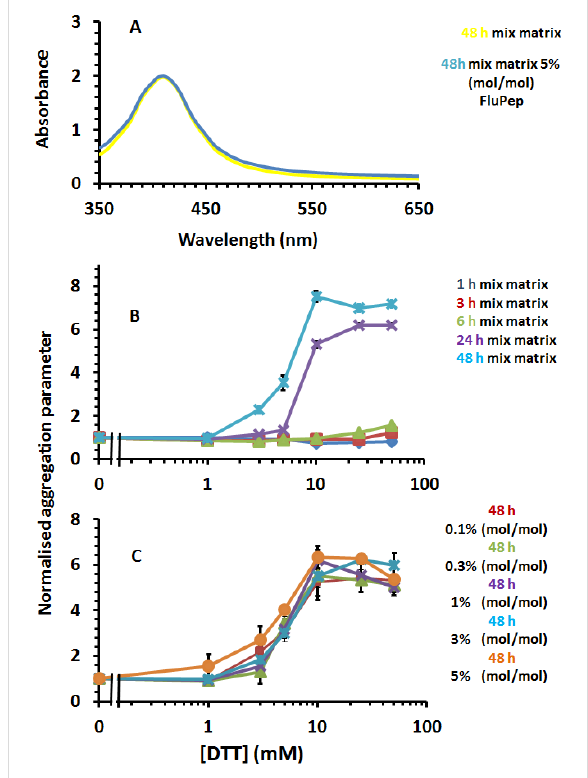
Figure 5: Stability of silver nanoparticles to DTT ligand exchange. (A) UV–vis spectra of mixed-matrix-capped silver nanoparticles and mixed-matrix-capped silver nanoparticles incorporating 5% (mol/mol) FluPep ligand in PBS. Time and dose-dependence of DTT